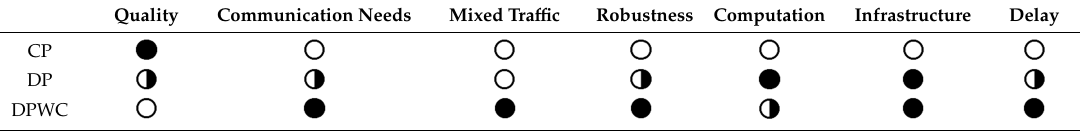
Table 2. Evaluation of the three planning levels for cooperation (circle: full = positive, empty = negative). CP: centralized planning; DP: decentralized planning with coordination; DPWC: decentralized planning without coordination.